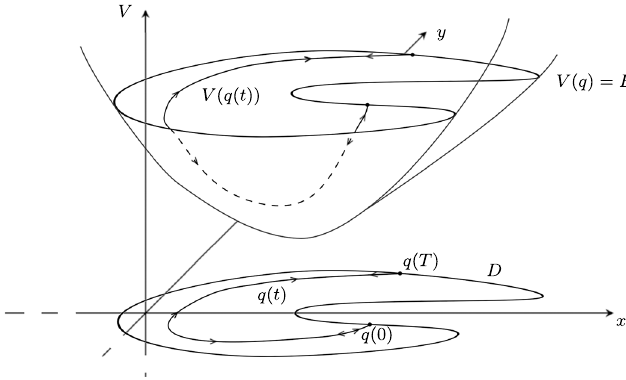
Figure 1: Projection on the con fi guration space of a break - orbit. The periodic solution q t ( ) oscillates back and forth between the two points q q T 0 , ( ) ( ) that lies on the boundary of the potential well D q V q